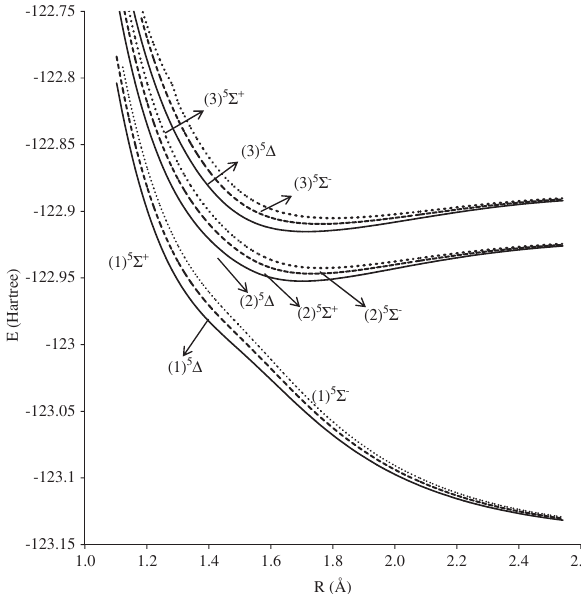
Figure 1: Potential energy curves of the electronic states 1 Σ ± and 1 Δ of the molecule BF.